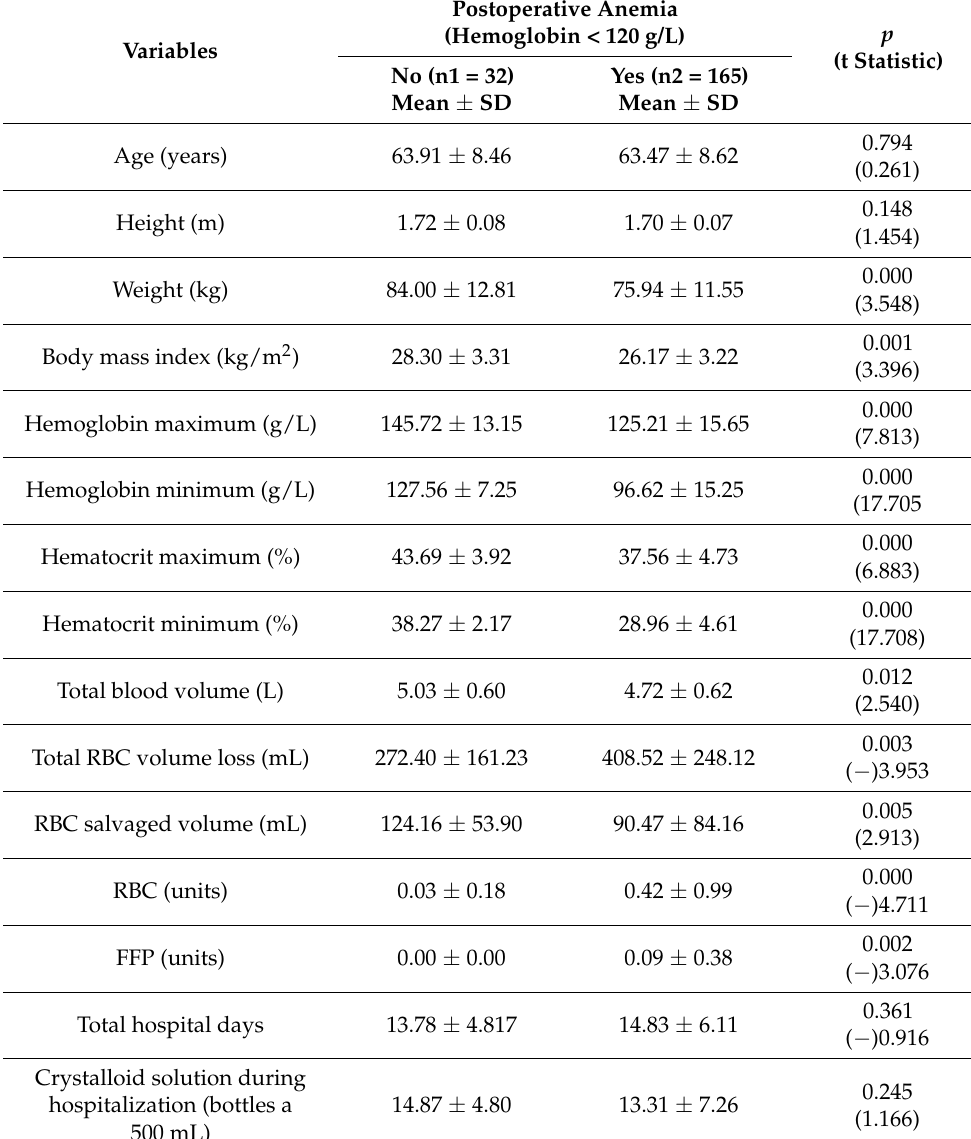
Table 2. Assessment of differences between orthopedic patients without vs. with postoperative anemia according to continuous